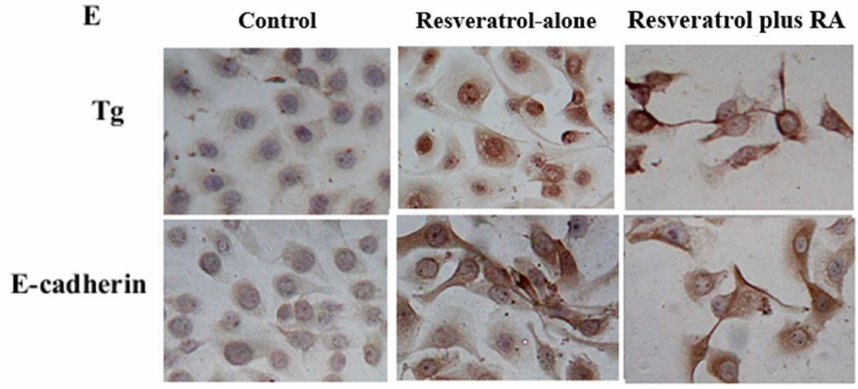
Figure 3. Resveratrol reverses the retinoic acid sensitivity of THJ-11T cells. ( A ) H/E staining ( × 40); ( B ) deoxynucleotidyl transferase-mediated dUTP-biotin nick and labeling assay (TUNEL) for apoptotic cell labeling (Green in color; × 40); ( C ) MTT cell proliferation assay; ( D ) viable cell counting; ( E ) immunocytochemical staining of thyroglobulin (Tg) and E-cadherin ( × 40). Control, cultured in 0.2% dimethylsulfoxide (DMSO)-containing medium; RA, retinoic acid treatment; Res, resveratrol treatment; Resveratrol plus RA, treated with a combination of 10 µ M retinoic acid and 100 µ M resveratrol for 48 h; Resveratrol-alone, 100 µ M resveratrol; *, with statistical significance ( p < 0.05); the error bars, the mean ± standard deviation. Arrows indicate the ports with higher magnification ( × 80) in the